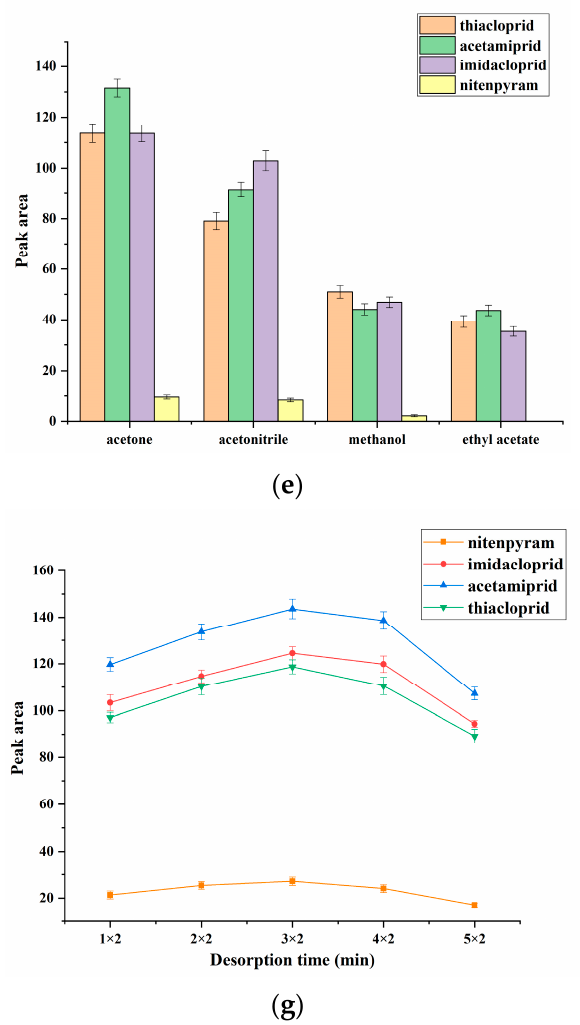
Figure 7. Effects of ( a ) dosage of MIL-53, ( b ) extraction time, ( c ) sample solution pH, ( d ) salinity, ( e ) eluent type, ( f ) eluent volume, and ( g ) elution time on the DME efficiencies for four neonicotinoid insecticides. Extraction conditions: sample volume, 50 mL; concentration of each neonicotinoid